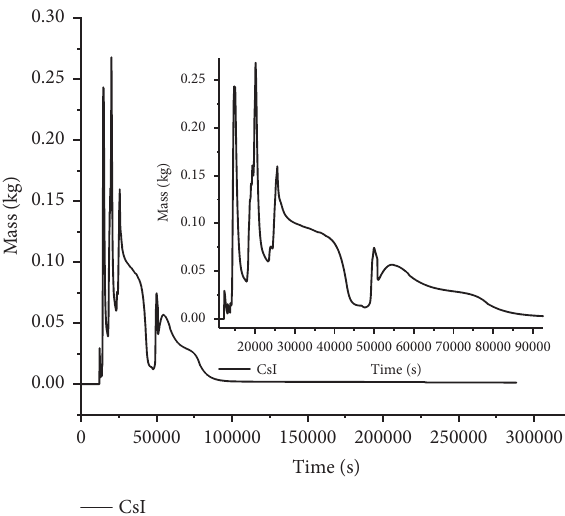
Figure 9: Release of I in the containment.